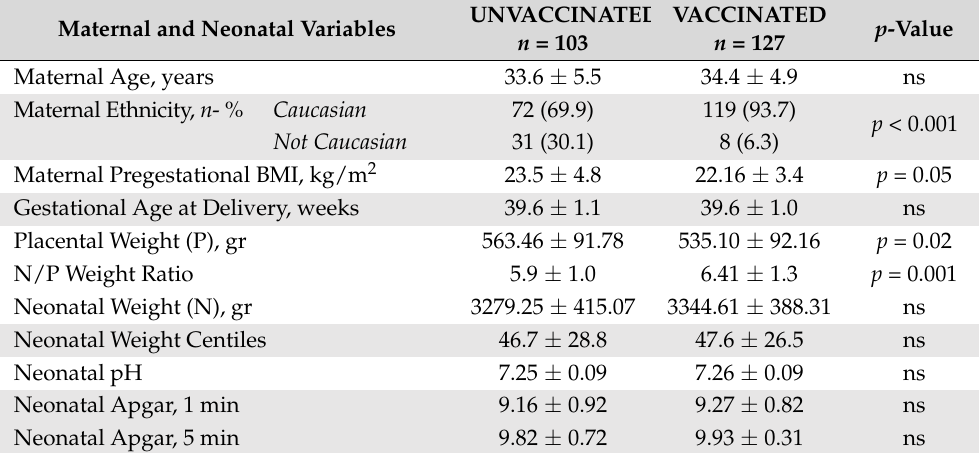
Table 2. Vaccinated vs. unvaccinated pregnant women: maternal data and delivery, placental and neonatal